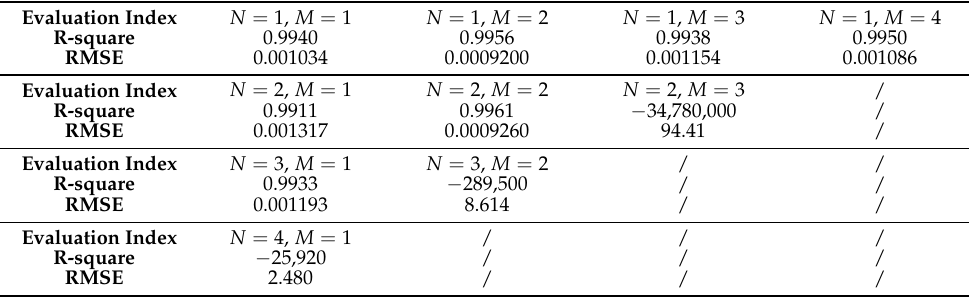
Table 2. Goodness-of-fit for polynomial models of different